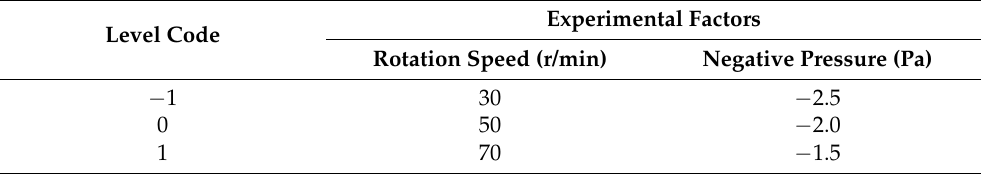
( d ) Figure 13. Velocity vector diagram of the suction hole section. a ) Cylindrical-shaped suction hole; ( b ) Funnel-shaped suction hole; ( c ) Horn-shaped suction hole; ( d ) Diabolo-shaped suction hole. 4.1.2. Influence of Suction Hole Shape on Pressure Flow Field Figure 14 depicts the pressure nephogram of the end section face with different- shaped suction holes. The pressure nephogram of the funnel and diabolo-shaped suction holes displayed a concentric circular stratified distribution; the pressure decreased from